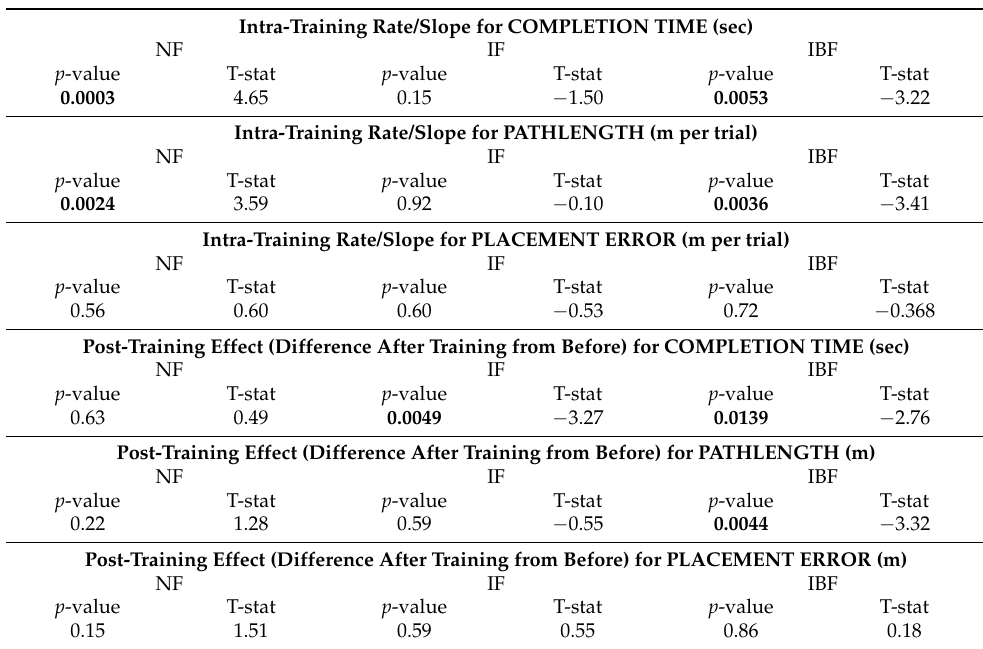
Figure 5. Example of linear regression fits to performance data of a single metric (completion time) shown across thirty sequential training trials for each of three feedback training conditions. Each ‘case’ represents the same subject with a distinct combination in trends of the regression slopes, i.e., intra-training rates. A ‘positive’ (desirable) intra-training rate is a decline in the performance